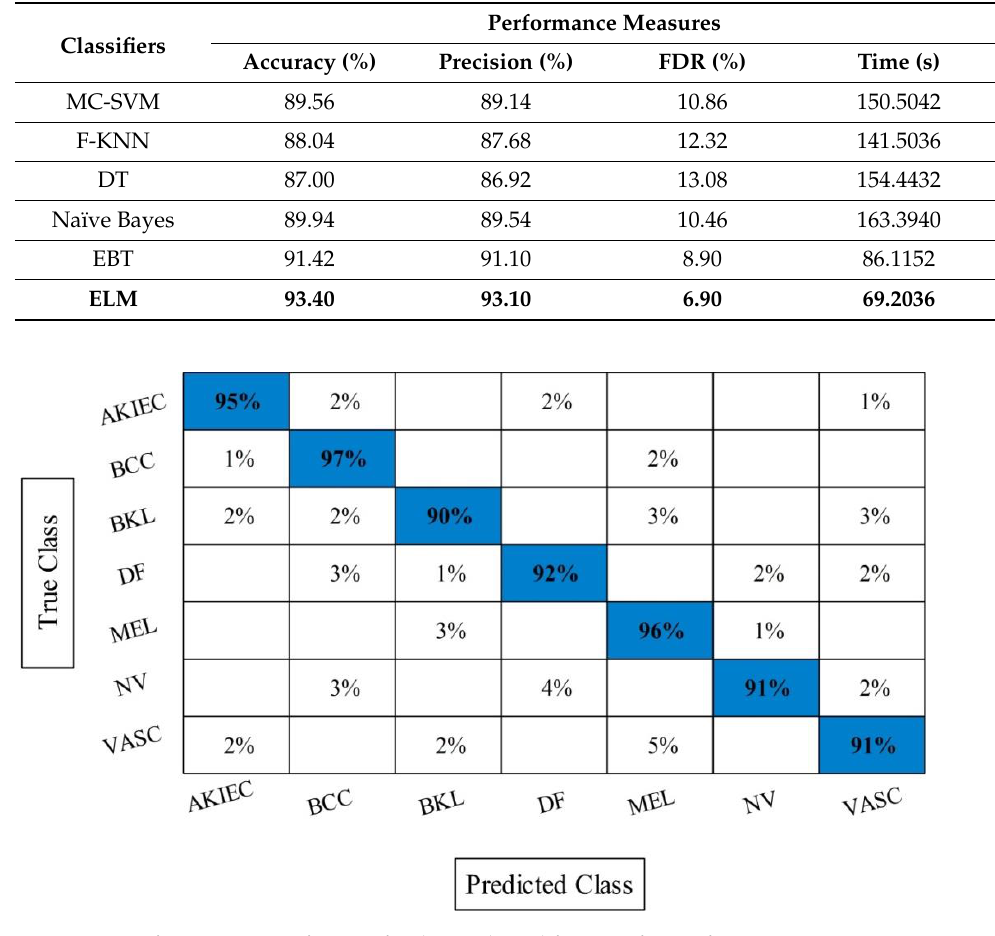
Figure 9. Confusion matrix of ELM after best selected features fusion for HAM10000.